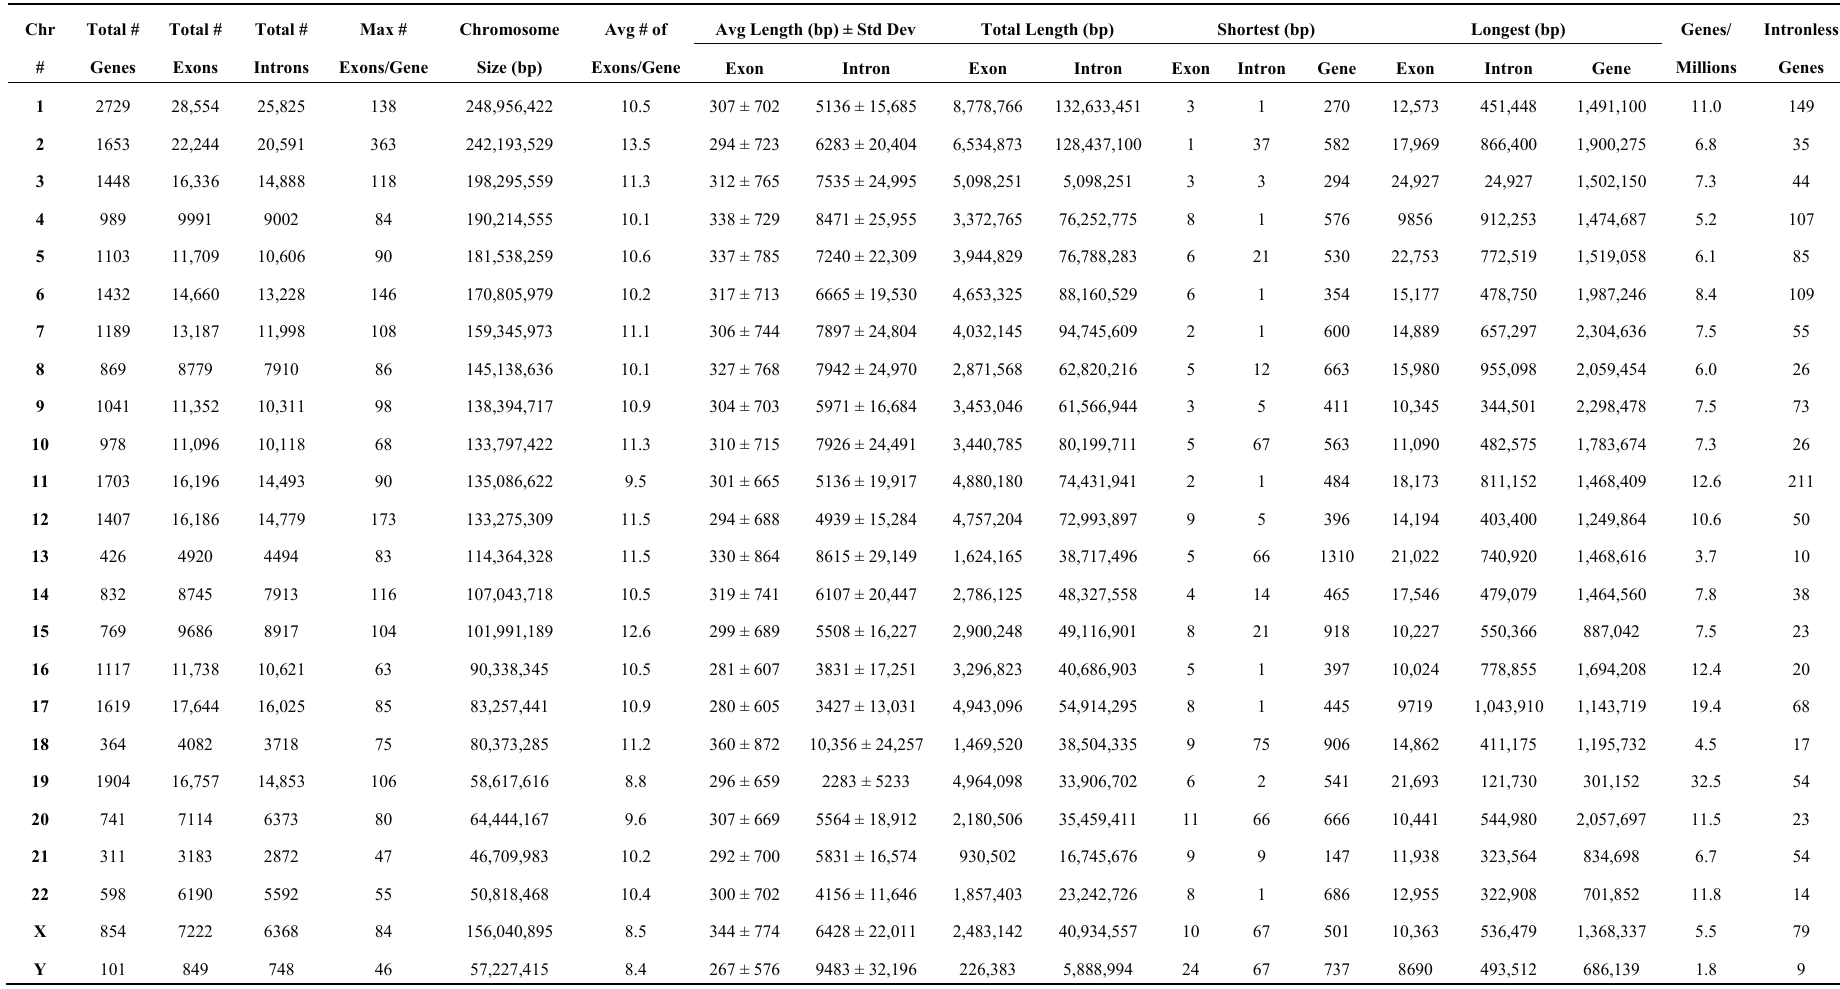
Table 2. Exons and introns distribution across human coding genes. Human genome data was downloaded from the UCSC main table browser (GCRh38, December 2013 build). Data was processed using tabular software. Analysis was performed using 26,177 coding genes, containing 278,420 exons and 252,243 introns. See the caution in Table 1 for the shortest introns (<30–40